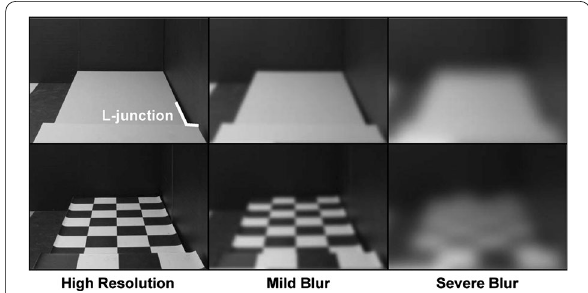
Fig. 4 The step‑down target used in Bochsler et al. (2012). Reprinted with permission from Wolters Kluwer Health, Inc. The